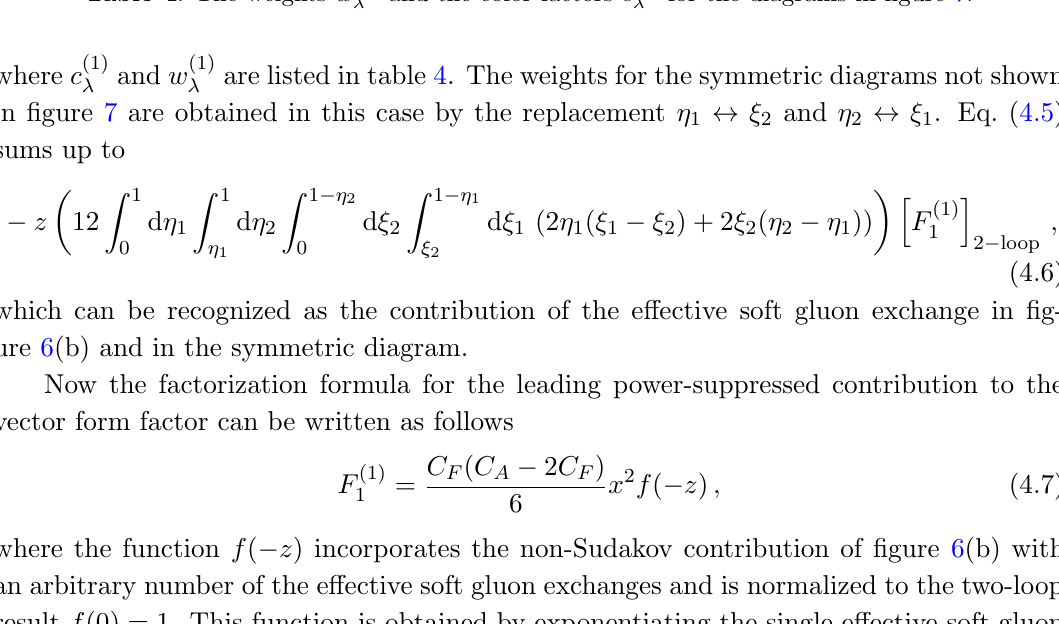
and the color factors c (1) (cid:21)